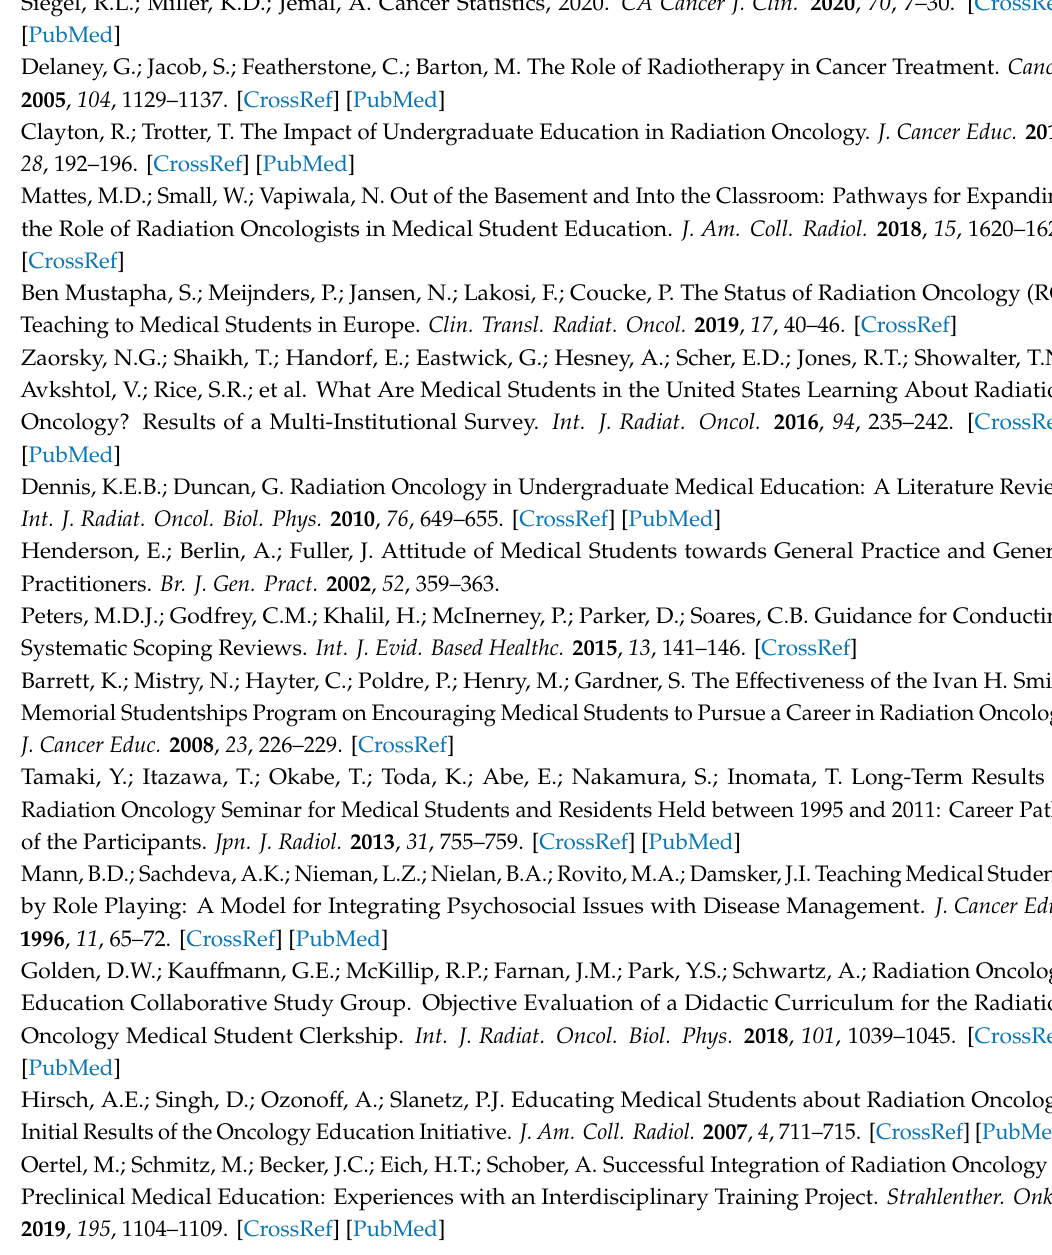
Table S1: Summary of study outcomes grouped by intervention